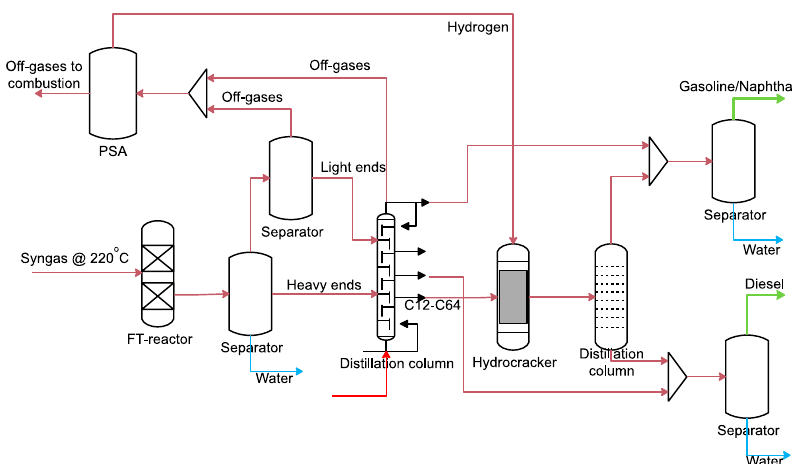
Figure 7. Process flow diagram of FT diesel and FT gasoline synthesis from syngas produced from waste gasification.